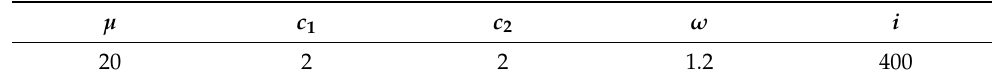
Table 2. Parameters of